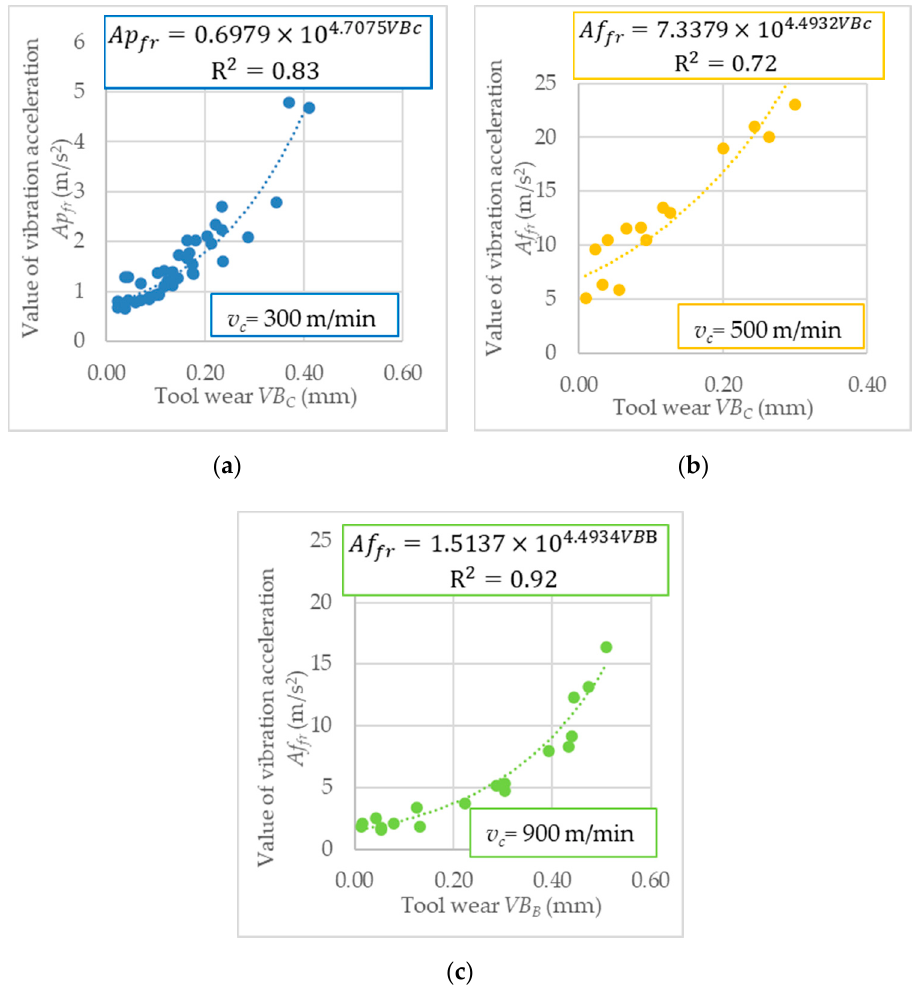
Figure 5. Diagnostic measures of vibration acceleration’s in: ( a ) frequency domain, v c = 300 m / min; ( b ) time domain, v c = 500 m / min; and ( c ) frequency domain, v c = 900 m / min; as a function of tool